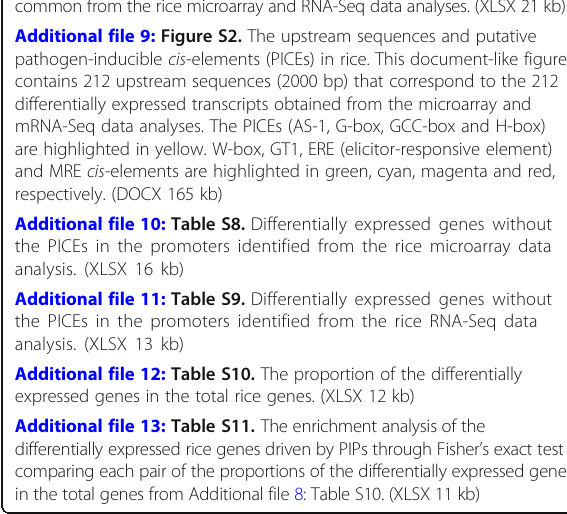
Abbreviations AS-1: activation sequence-1; bZIPs: the basic/Leu zipper transcription factors; DRR: disease resistance-related; DSR: disease susceptibility-related; ERFs: ethylene-responsive element binding proteins; ET: ethylene; ETI: effector-triggered immunity; GEO: Gene Expression